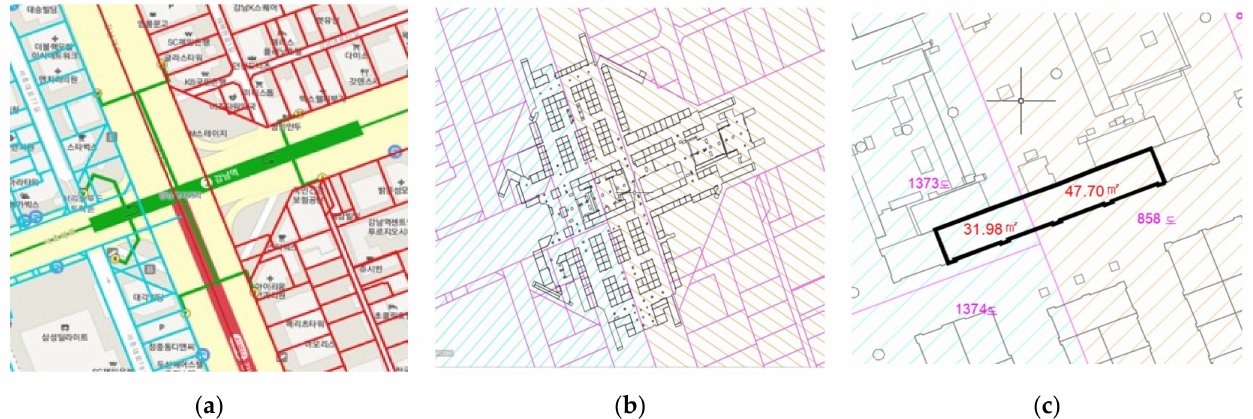
Figure 7. Generating horizontal location status information with above-ground parcels. ( a ) Boundary between the underground shopping center and administrative district. ( b ) Boundary between the underground shopping center and above-ground parcel (administrative area). The blue diagonal line on the left is Seocho-dong, and the orange diagonal line on the right is Yeoksam-dong. ( c ) Boundary between individual stores and above-ground